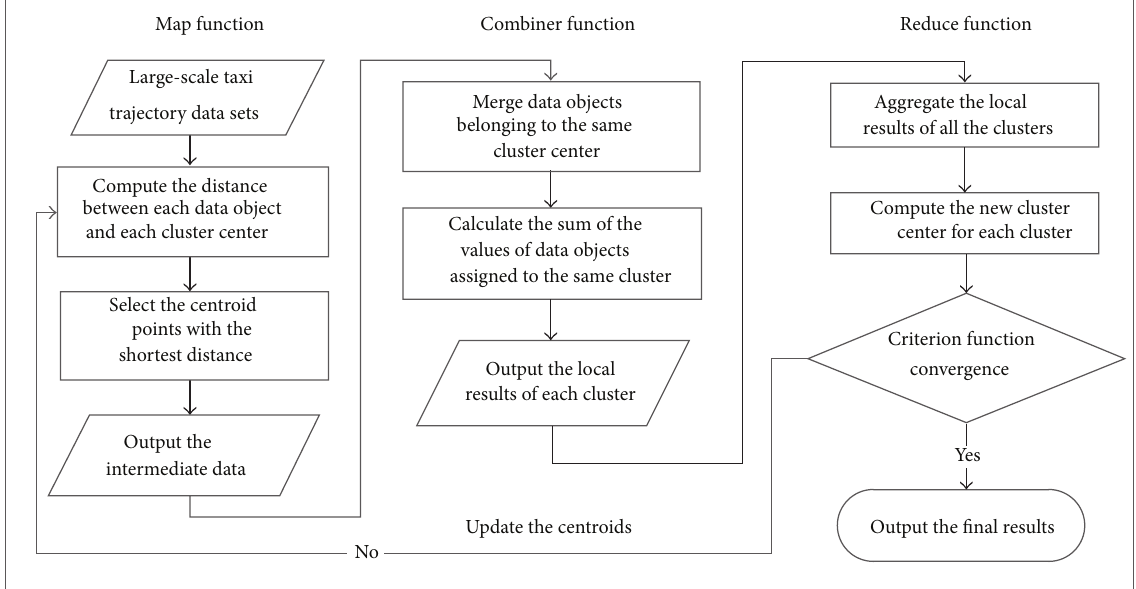
Figure 7: Parallel execution process of